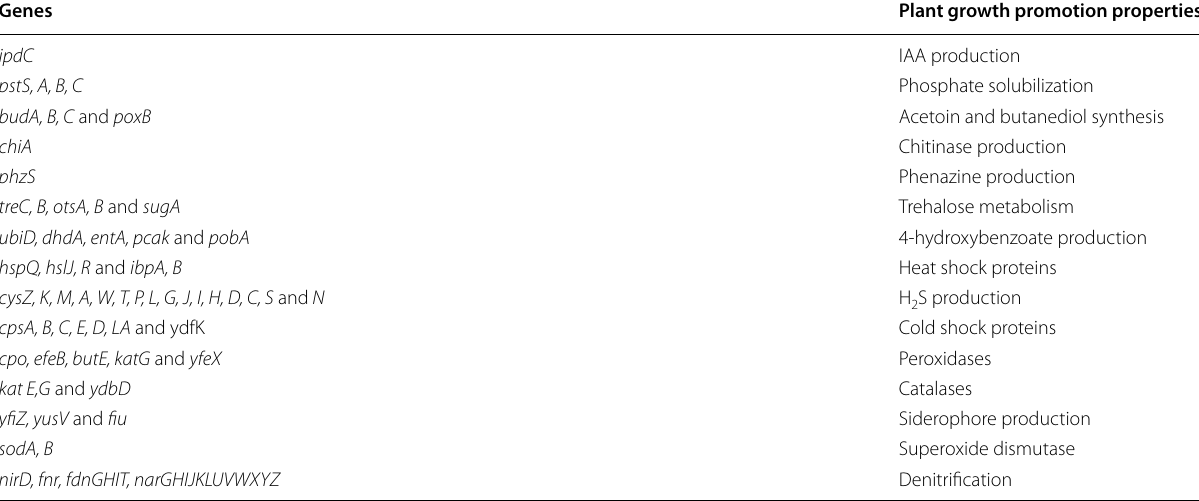
Table 5 List of plant growth promoting genes in R. planticola FACU3